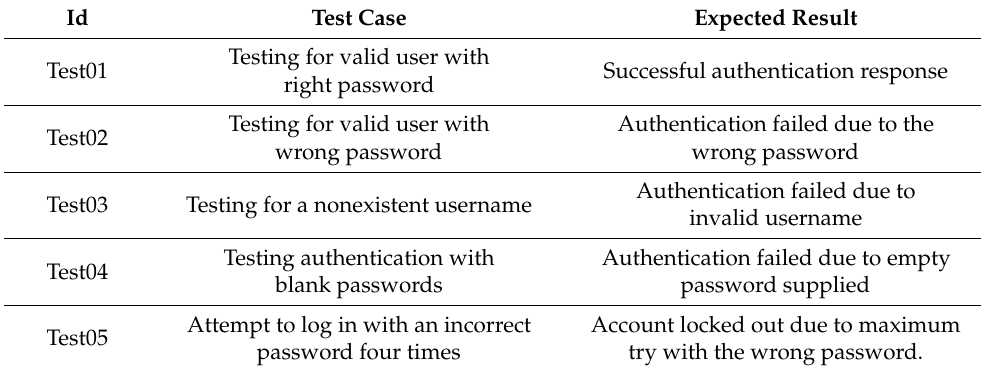
Table 11. Sample acceptance criteria for unit